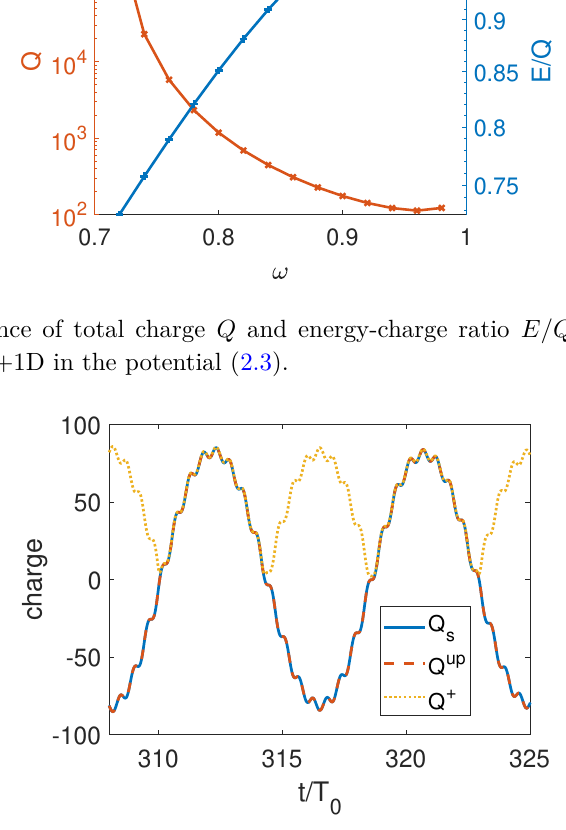
Figure 29. Charge swapping patterns of a dipole CSQ in 3+1D. Q s , Q up and Q + are defined analogously to those in section 2.1; see figure